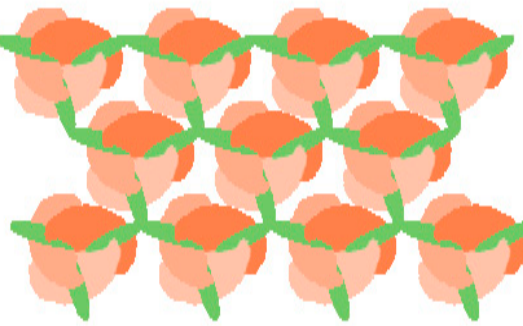
Figure 3. Multivalent SUN–KASH interactions. The interaction of nesprin with neighbouring SUN trimers enables the formation of higher-order complexes; i.e., the association of the KASH domain from trimeric/oligomeric nesprins with neighbouring SUN trimers allows for higher-order arrays of the LINC complex. Orange and green molecules represent SUN and KASH peptides, respectively.